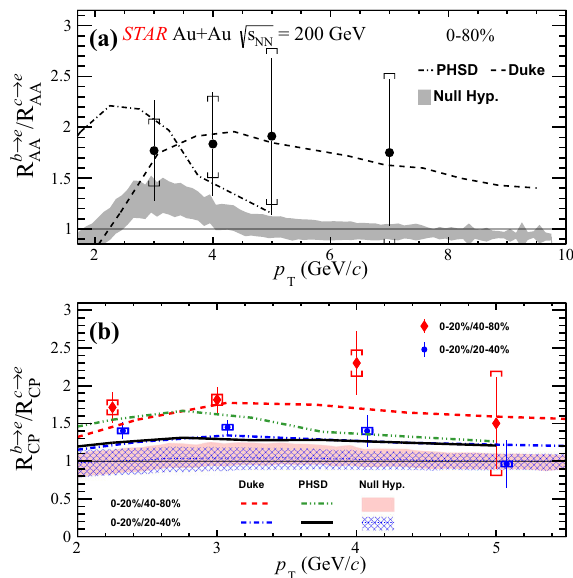
The abundances of (cid:11) c / b are matched to data in Refs. [47,64].